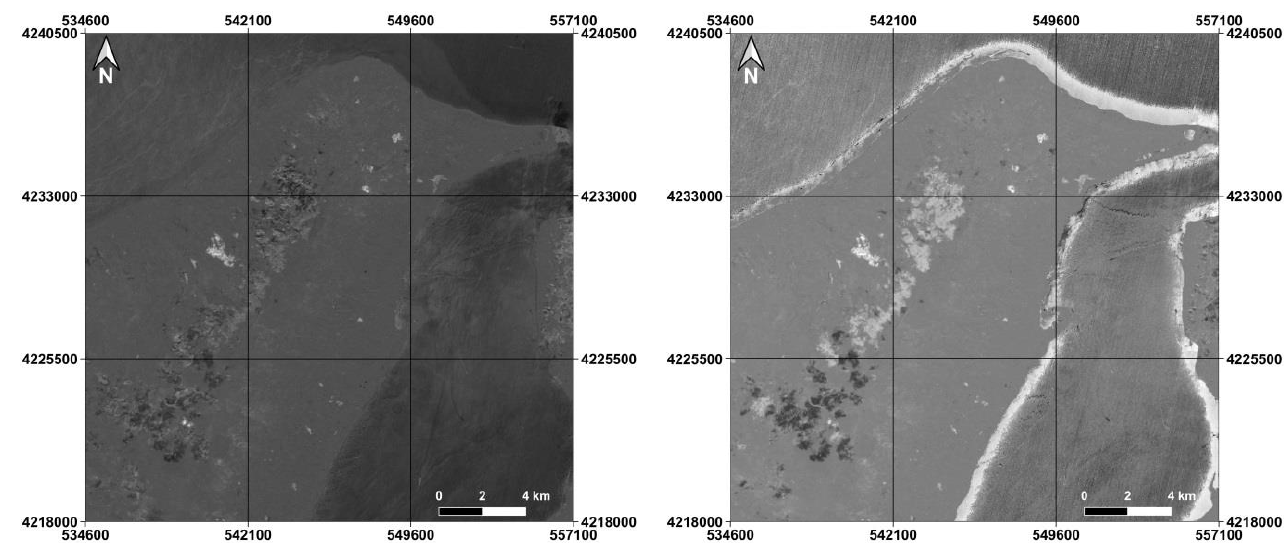
Figure 6. Comparison between ΔNBR+ ( left ) and ΔNBR ( right ).